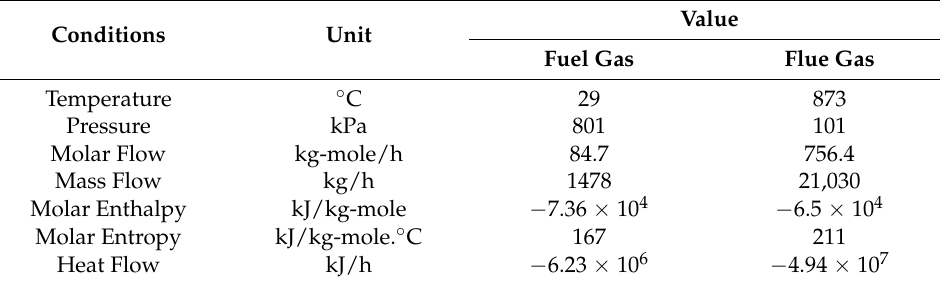
Table 4. Conditions of fuel gas and flue gas.